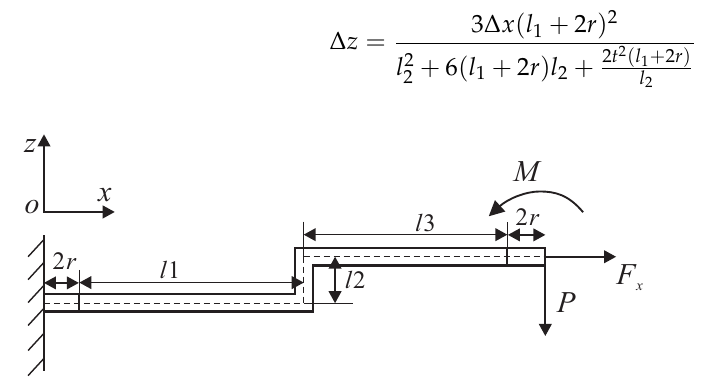
Figure 5. Single Z-shaped flexure hinge force